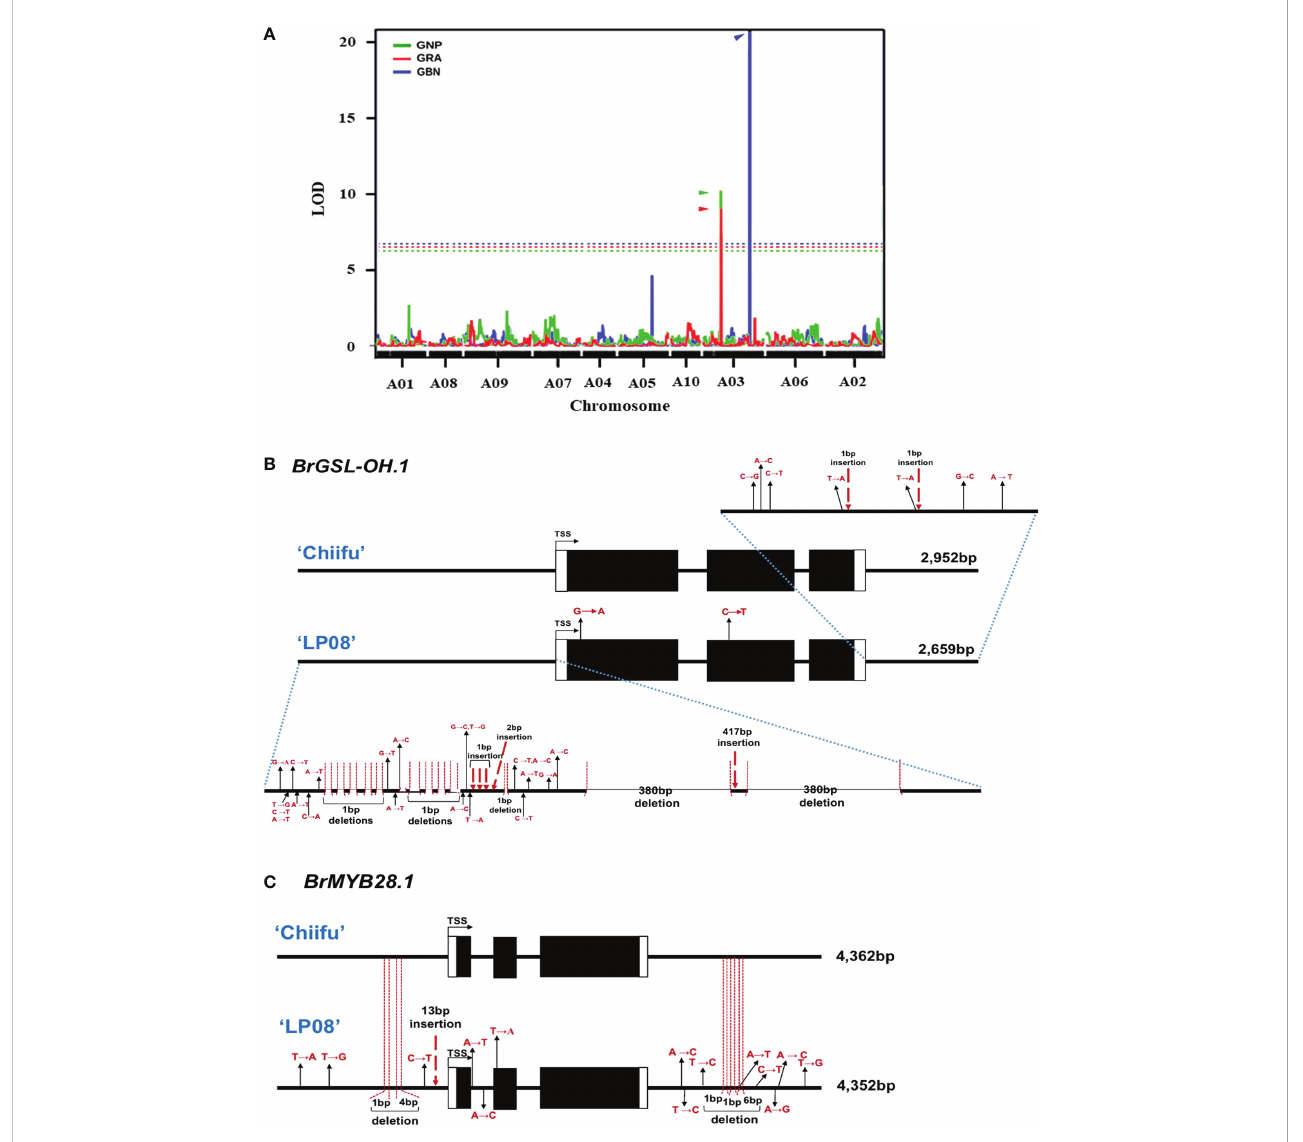
FIGURE 8 Identi fi cation of major QTL genes controlling GSL content in ‘ Chiifu ’ and ‘ LP08 ’ . (A) Results of QTL mapping of 97 F 5 RILs and parental lines using HPLC data for GSL contents under long-day conditions. The X-axis represents the chromosomes (in order), and the Y-axis represents the limit of detection (LOD). Two peaks exceeding the LOD threshold for GRA and GNP were detected in the upper and lower arm regions for GBN in chromosome A03. The picture is made by overlapping three pictures to show the location of QTL peaks well. Green, red, and blue lines indicate the QTL peaks of GNP, GRA, and GBN, respectively and each threshold (dotted lines) is 5.454, 5.906, and 6.745. (B) Comparison of genomic structures of BrGSL-OH.1 between ‘ Chiifu ’ and ‘ LP08 ’ . The entire 2,952- and 2,659-bp genomic sequences of BrGSL-OH.1 were ampli fi ed through PCR from ‘ Chiifu ’ (upper) and ‘ LP08 ’ (lower), respectively. Comparison of the coding region of BrGSL-OH.1 revealed two single-base substitutions (marked with black arrows) in the fi rst and second exon of ‘ LP08 ’ . Compared to BrGSL-OH.1 in ‘ Chiifu ’ , the promoter region of BrGSL-OH.1 in ‘ LP08 ’ had numerous single-base substitutions (marked with black arrows), along with 10 deletions (indicated with vertical dotted lines). Two large 380-bp deletions and one 417-bp insertion were identi fi ed in the promoter region of ‘ LP08 ’ . In the 3 ′ downstream region, seven single-base substitutions (marked with black arrows) and two single-base deletions (indicated with vertical dotted lines) were identi fi ed in ‘ LP08 ’ compared to ‘ Chiifu ’ . (C) Comparison of the genomic structures of BrMYB28.1 between ‘ Chiifu ’ and ‘ LP08 ’ . The entire 4,362- and 4,352-bp genomic sequences of BrMYB28.1 were ampli fi ed by PCR from ‘ Chiifu ’ (upper) and ‘ LP08 ’ (lower), respectively. Compared to ‘ Chiifu ’ , four single-base substitutions (marked with black arrows), one single-base deletion and one 4-base deletion (indicated with vertical dotted lines), and one 13-bp insertion (marked with red dashed arrow) were identi fi ed in the promoter region of ‘ LP08 ’ . In the coding sequence region, two single-base substitutions and one single-base substitution were detected in the fi rst intron and second exon region, respectively, in ‘ LP08 ’ . The 3 ′ downstream region of BrMYB28.1 in ‘ LP08 ’ contained eight single-base substitutions (marked with black arrows) and three deletions (indicated with vertical dotted